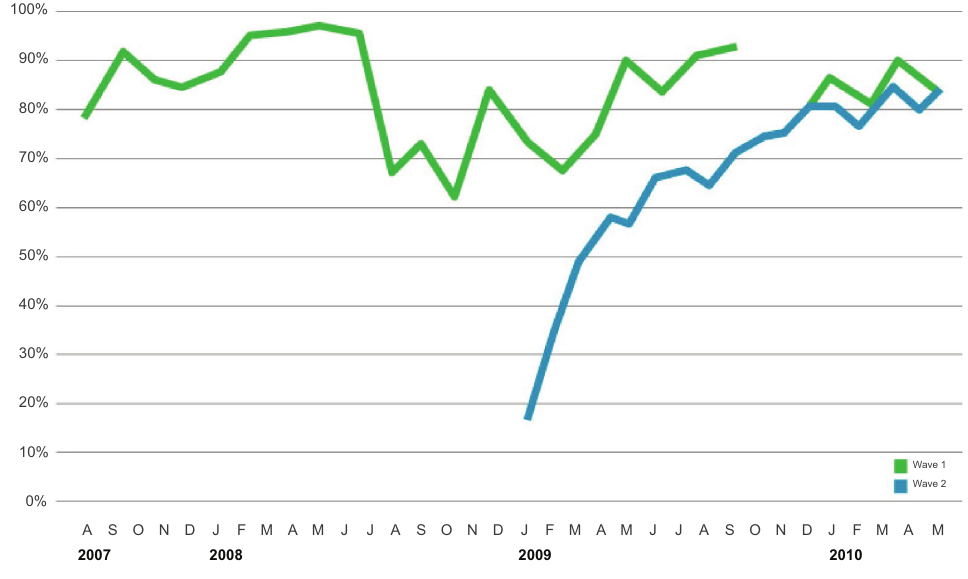
Figure 9. Guatemala: compliance with Prenatal Care Criteria. The rate of adoption of compliance with Prenatal Care Criteria in wave 2 was much faster than in wave 1.